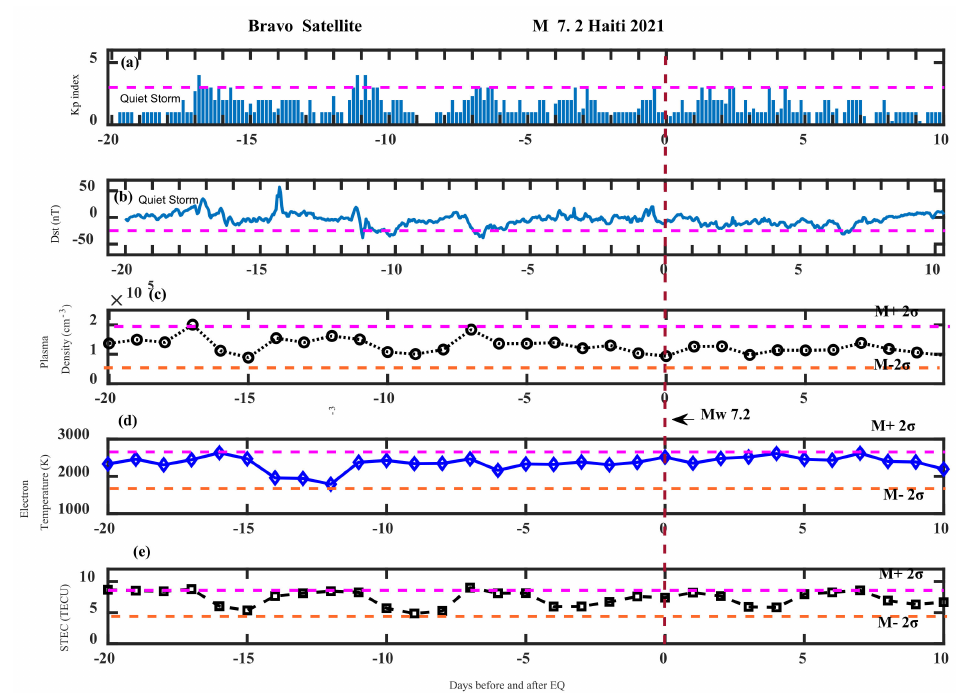
Figure 8. ( a ) and ( b ) The storm display of Dst and Kp for M w 7.2 (Haiti). ( c ) Plasma density ( d ) Electron Temperature (ET) ( e ) STEC of Swarm-B for M w 7.2 (Haiti). The red dashed line represents the EQ day.